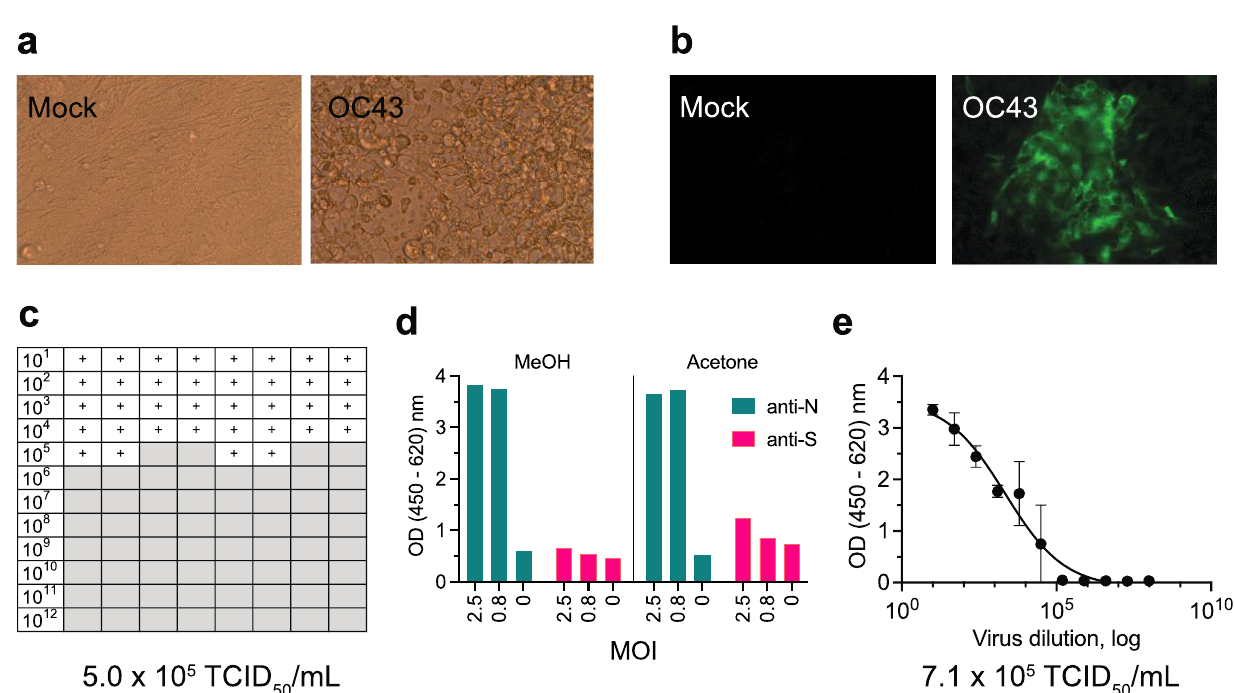
Figure 1. Comparison of methods to determine the titer of OC43. HCT-8 monolayers were infected with serial 10-fold dilutions of OC43 viral stocks from 1:10 to 1:10 12 . ( a , c ) Wells were visually examined for cytopathic effect (CPE) with light microscopy and scored as having CPE (+) or not having CPE (gray boxes) at day 8 postinfection. ( b ) Virus was also visualized by fluorescent microscopy using rabbit anti-OC43 N antibody followed by AF488-conjugated goat anti-rabbit antibody on day 3 post infection. “Mock” refers to negative control wells mock -infected with PBS. ( c ) The TCID 50 was calculated based on CPE on day 8 using the Reed – Muench method. Each box represents a well of a 96-well microtiter plate. The titer was calculated from two independent experiments, each run in quadruplicate. ( d ) Comparison of using methanol (MeOH) versus acetone fixation and using rabbit anti-OC43 N antibody versus rabbit anti-OC43 S antibody to detect OC43 infection of HCT-8 cells. The secondary antibody used was horseradish peroxidase-conjugated goat anti-rabbit antibody and the OD was measured on day 5 postinfection with OC43 at a multiplicity of infection (MOI) of 2, 0.8, and 0 (no virus). ( e ) The TCID 50 was calculated based on staining with rabbit anti-OC43 N antibody followed by horseradish peroxidase-conjugated goat anti-rabbit antibody on day 5 postinfection. Each data point represents the mean and standard error of four independent replicates. The ODs obtained from the “cells only” negative controls were defined as background and subtracted from all measurements.